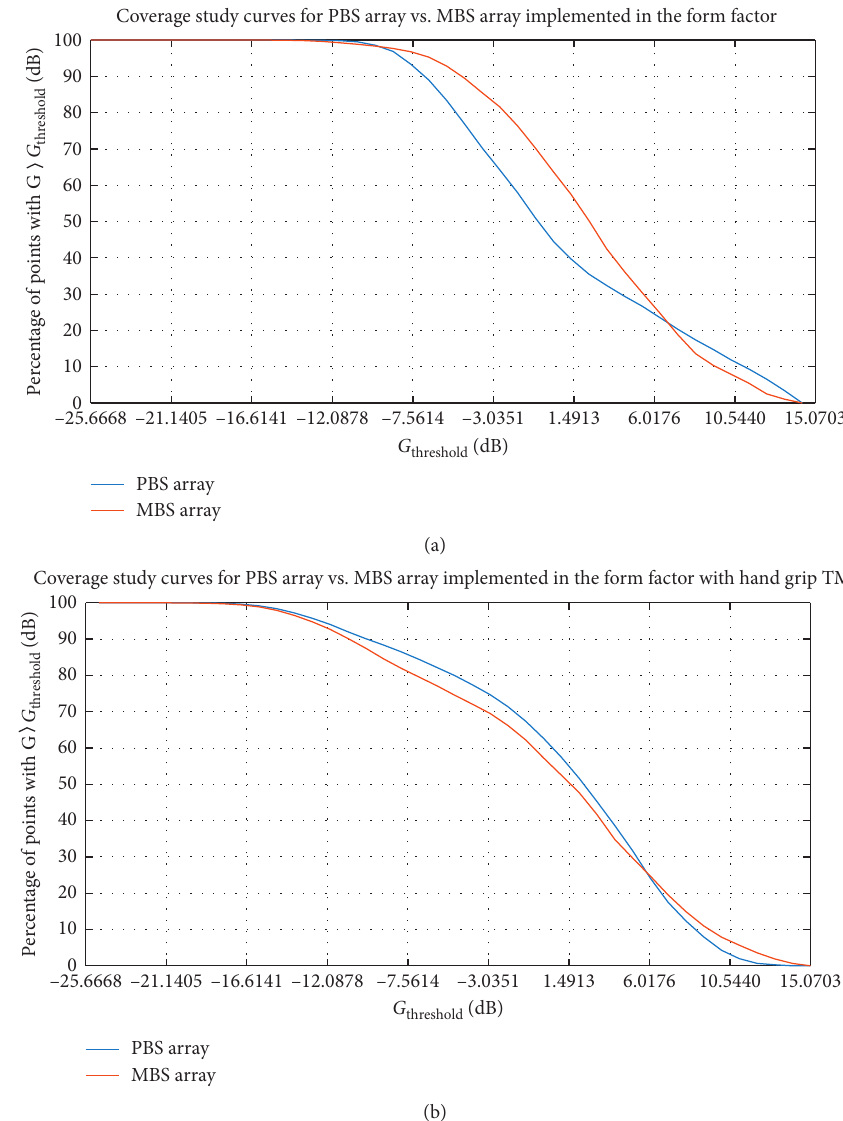
Figure 21: Coverage curves for PBS vs. MBS implemented in the smartphone (TM: Talk Mode hand grip): (a) without user presence; (b) with hand grip.